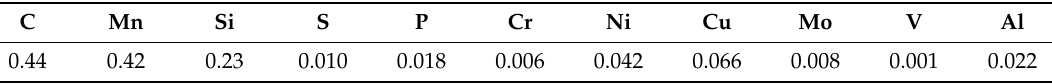
Figure 3. Illustration of ( a ) α = 60 deg die, ( b ) initial specimen and ( c ) specimen after upsetting. Table 1. Nominal chemical composition of C45E steel (mass fraction,